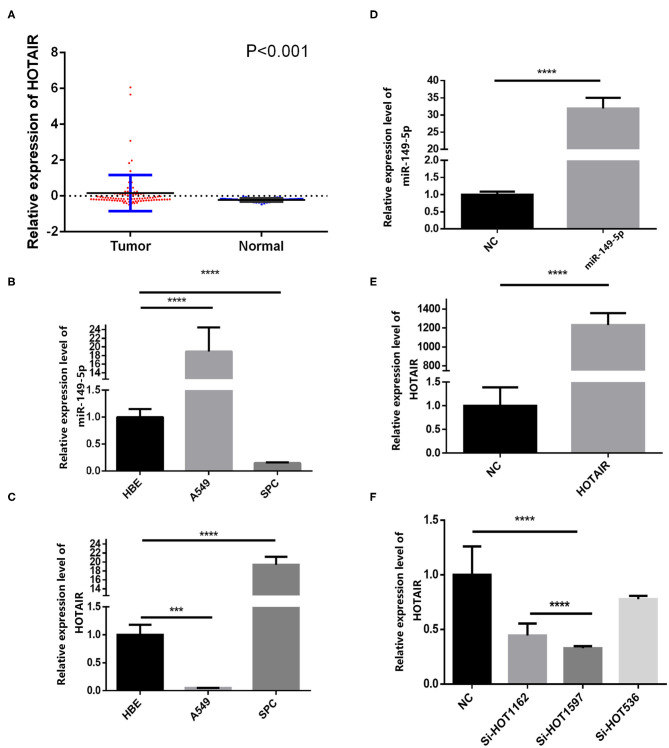
Relative expression of HOTAIR in non-small cell lung cancer tissues and normal lung tissues and QRT-PCR results of HOTAIR and miR-149-5p in A549 and SPCA1 cell lines and transfected cells. (A) Relative expression of HOTAIR in non-small cell lung cancer tissues and normal lung tissues from the GEO data set. (B) Background expression of miR-149-5p in HBE, A549, and SPC-A-1 cell lines. (C) Background expression of HOTAIR in HBE, A549, and SPC-A-1 cell lines. (D) Relative expression of miR-149-5p in SPC-A1 cells transfected by miR-149-5p overexpression lentivirus. (E) Relative expression of HOTAIR in A549 cells transfected by HOTAIR overexpression lentivirus. (F) Relative expression of HOTAIR in SPC-A-1 cells after transfection by small inferring RNAs (siHOT-1162, siHOT-1597, and siHOT-536). ***P < 0.01; ****P < 0.05.